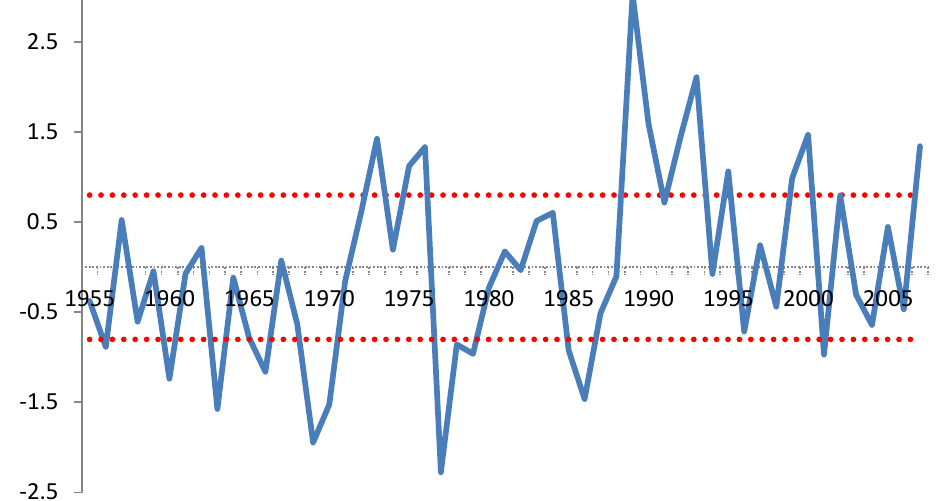
Figure 1. Artic Oscillation (AO) wintertime index during 1954–2007. https: // www.cpc.ncep.noaa.gov / products / precip / Cwlink / daily_ao_index / ao.shtml. Table 1. Classification of anomalous years based on the phases of wintertime AO index during 1954–2007. Positive AO.